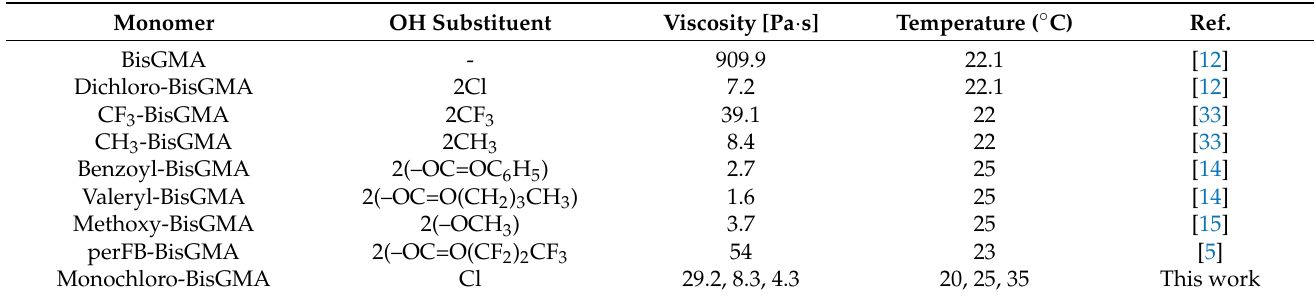
Table 4. Comparison of the viscosity of various BisGMA